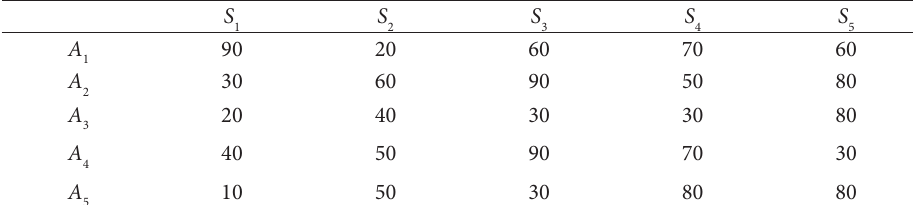
Table 2. Payoff matrix – Expert